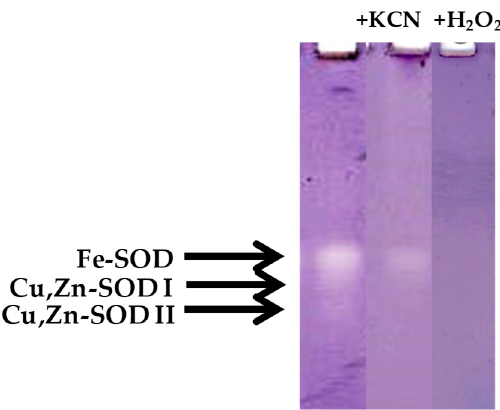
Figure 12. Pattern of superoxide dismutase (SOD) isoenzymes in native PAGE for peach ‘GEM020 ′ flower buds cultivated in two different geographical areas during the dormancy cycle. Samples from the temperate area at dormancy release are taken as representative. Gels were stained in the presence and in the absence of the selective inhibitors KCN or H 2 O 2 . Ten micrograms of proteins per line were loaded.